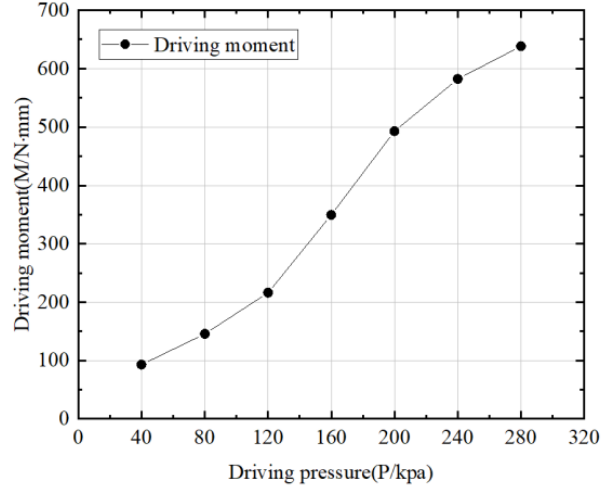
Figure 15. A characteristic curve of the hexagonal prism soft-bodied bionic actuator. For the designed soft-bodied pipe robot, the larger the bending angle and output moment of the hexagonal prism soft-bodied bionic actuator the worse, as the contact area between the actuator and the pipe decreases with the increase in bending angle. However, in the experiment, it is found that when the driving pressure is 80 kPa, the contact area between the actuator and the pipeline reaches the minimum value. With the increase in the driving pressure, the contact area does not change, but the output moment will continue to increase, and then the friction between the actuator and the pipeline will increase, and the high driving pressure will reduce the service life of the actuator and increase the maintenance cost. Therefore, 80 kPa can be set as the driving pressure of the axial bending deformation mode of the hexagonal prism soft-bodied bionic actuator.